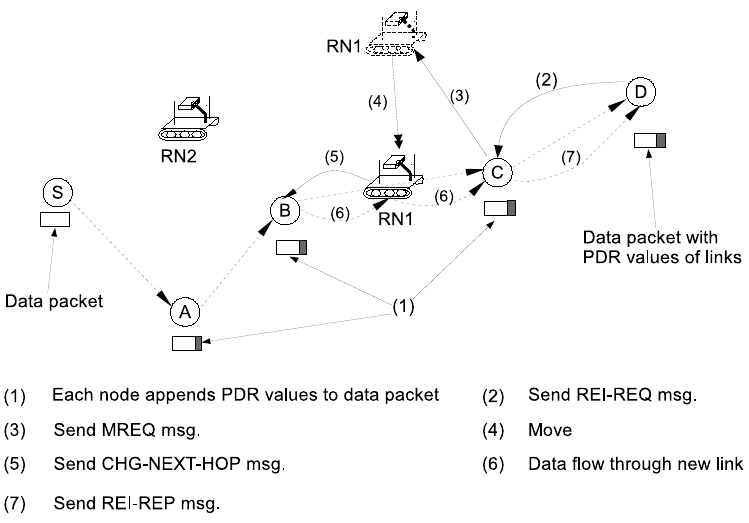
Figure 2. An example of link reinforcement